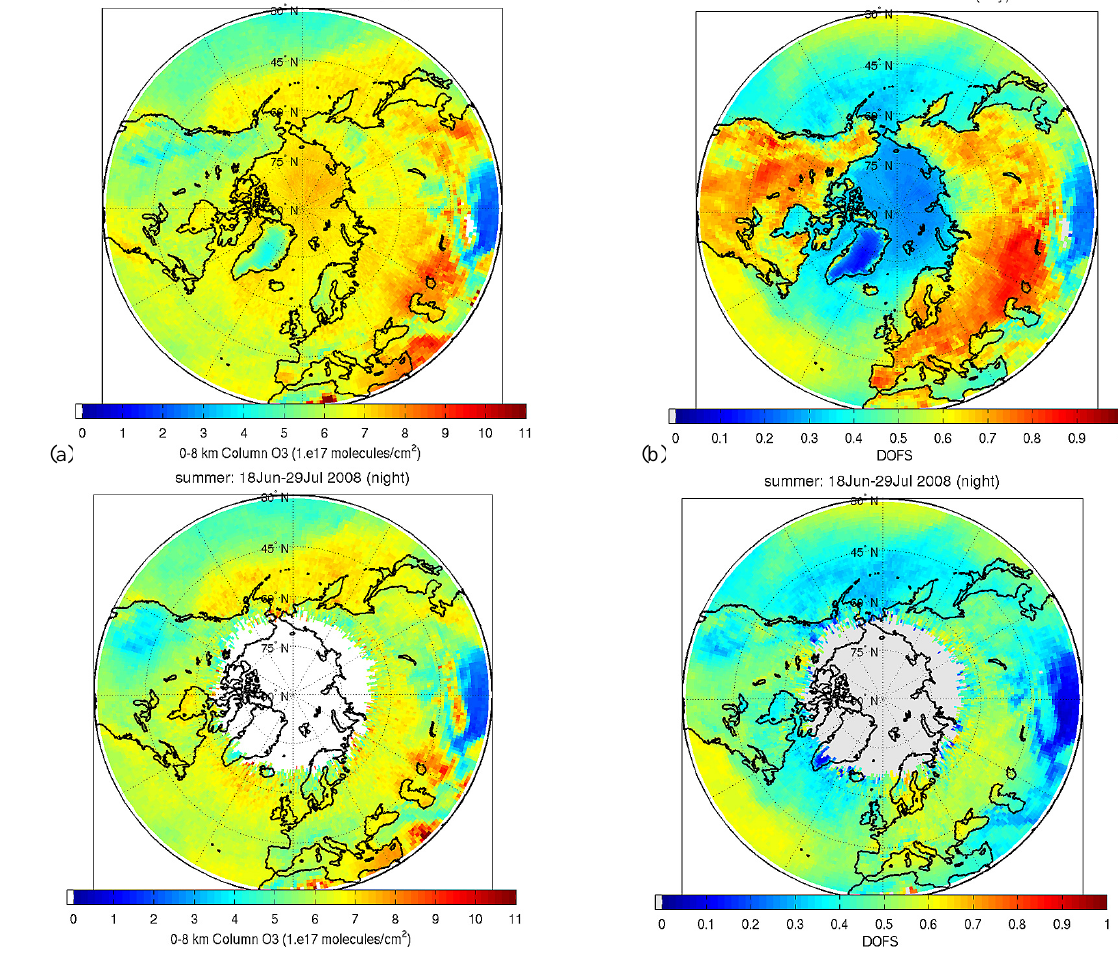
Fig. 5. Same as Fig. 4 for the summer period. White areas indicate no